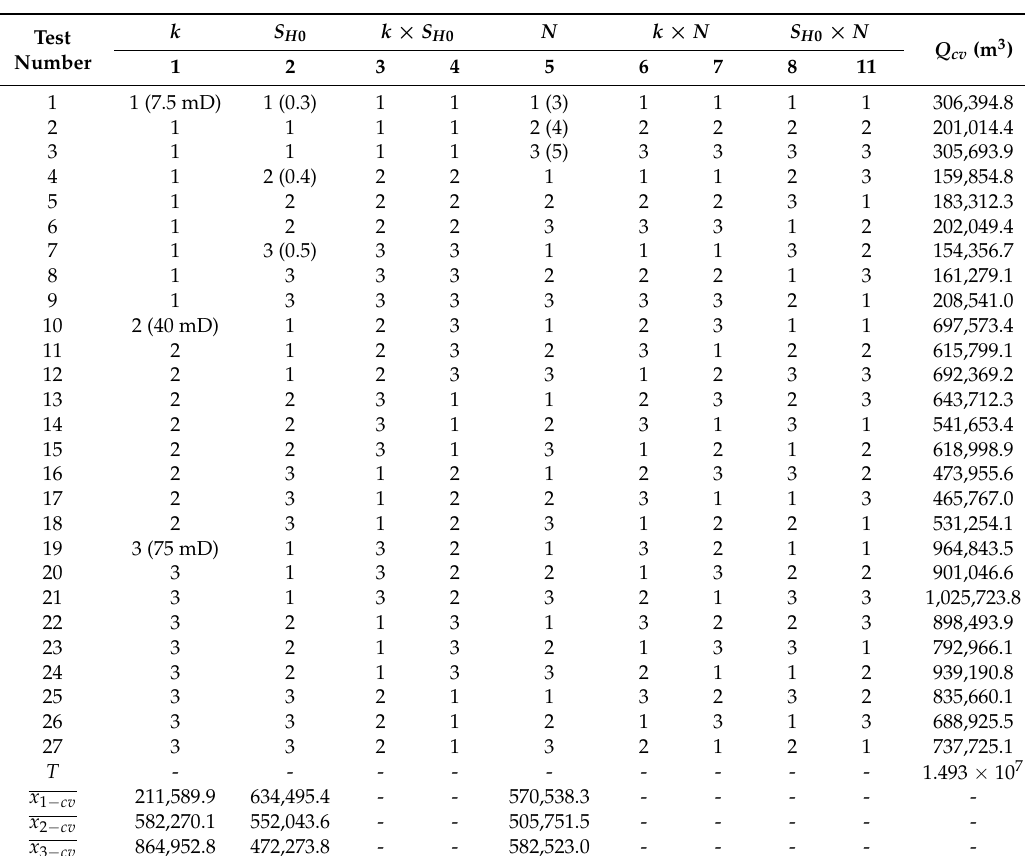
Table 5. L 27 (3) 13 whole simulation experiment and